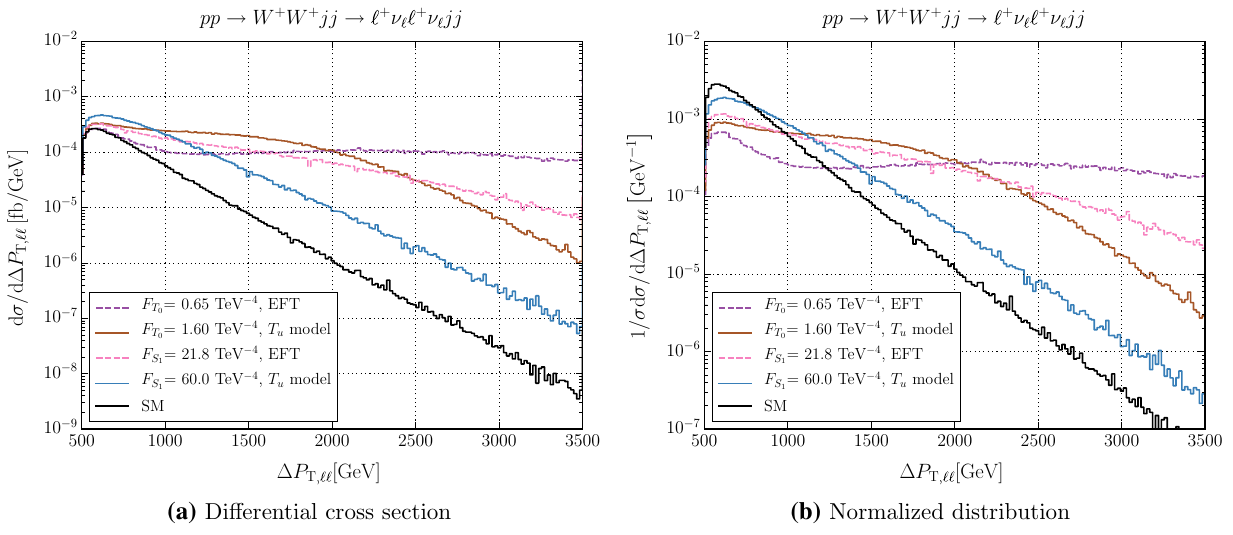
Fig. 7 Differential cross section as a function of (cid:24) p T ,(cid:6)(cid:6) for pp → (cid:6) + ν (cid:6) (cid:6) + ν (cid:6) jjX . The solid black line shows the SM, the dashed lines show the naive EFT prediction within current CMS bounds, and the